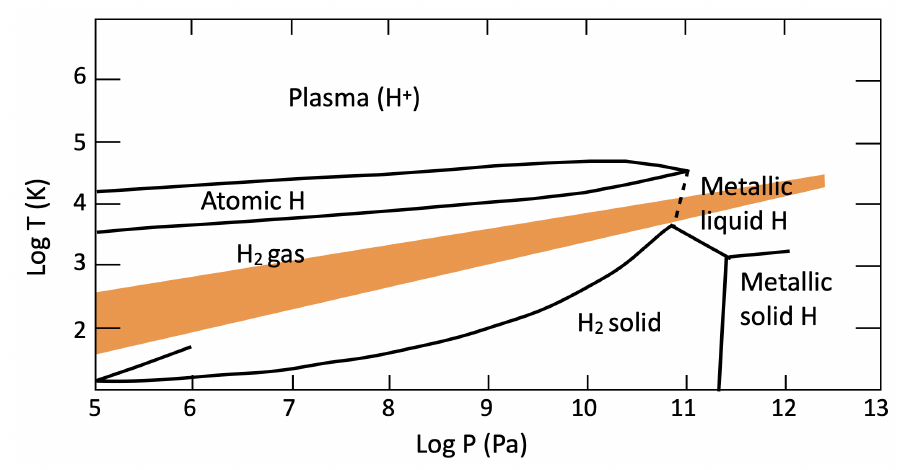
Figure 4. Phase diagram of hydrogen. The orange area represents the zone of interest for the interiors of the giant planets. Adapted from Miguel et al.